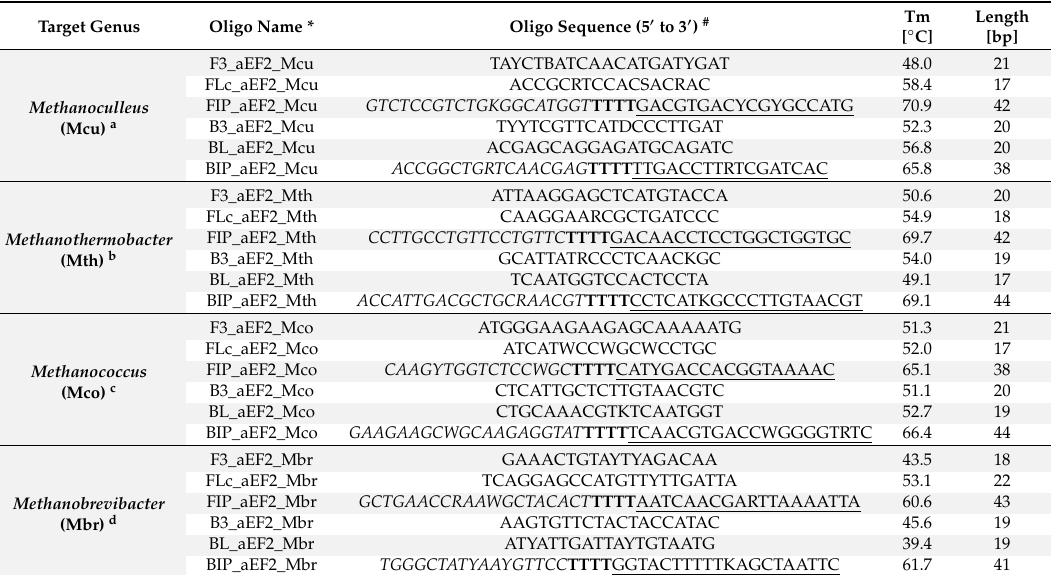
Table 1. Loop-mediated isothermal amplification (LAMP) primer sequences targeting various hydrogenotrophic methanogen